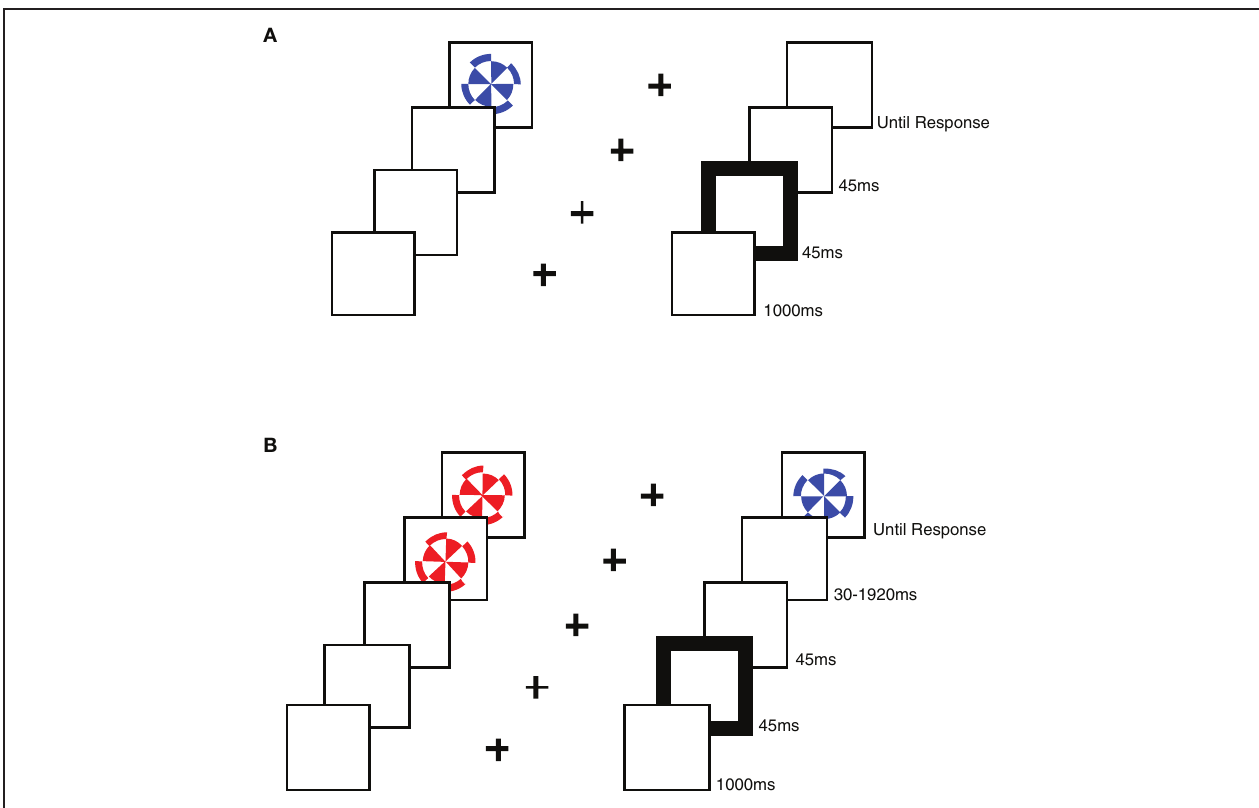
FIGURE 1 | A schematic representation of the stimuli used in each task. (A) An example sequence of stimuli in a RT task trial, showing a sequence from the uncued condition. (B) An example sequence of stimuli in a TOJ task trial, showing a sequence from the uncued, left-target condition.